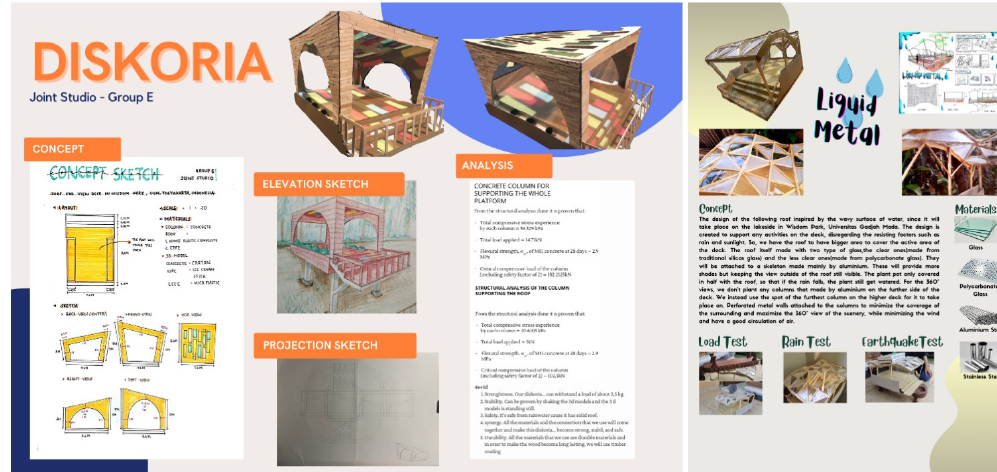
Buildings 2022 , 12 , x FOR PEER REVIEW Figure A2. Bambooring . Figure A2. Bambooring.